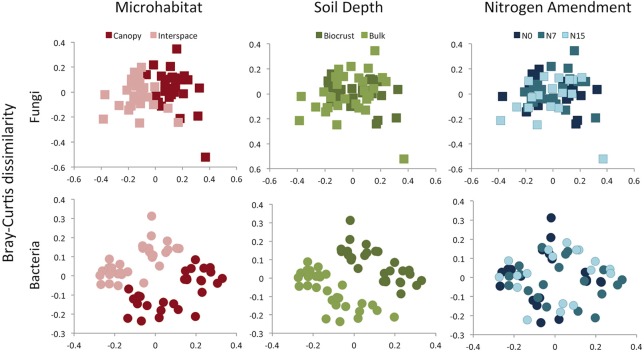
Bray-Curtis dissimilarity among fungal or bacterial communities, displayed as 2D MDS plots. Plots are color coded to show microhabitat (red), soil depth (green), or N amendment (blue) differences. While results are presented for individual treatments, results were analyzed using a three-way framework with PERMANOVA. See Results text for statistical support.